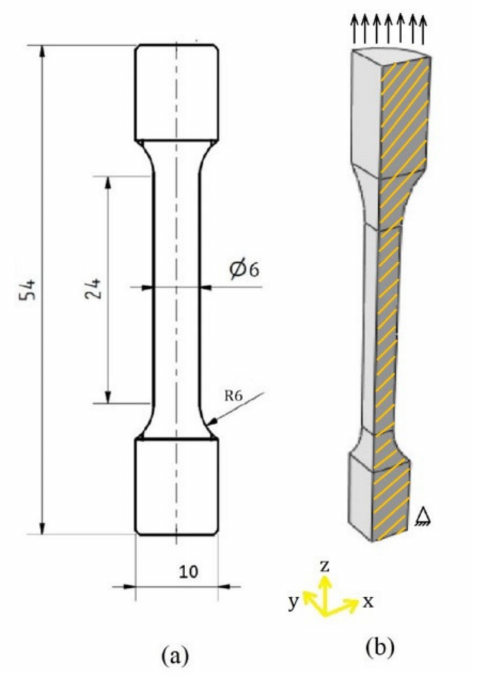
Figure 2. ( a ) Specifications of tensile specimen (all units are in mm) ( b ) tensile model for simulation. Displacement controlled loading was applied with the boundary condition of keeping one side fixed, while displacement loading is applied on the other end, as shown in Figure 2b. Two additional boundary conditions were used based on the assumption that the cross-section of the specimen remains circular during the tensile test; in xz plane (shaded by yellow color in Figure 2b), displacement and rotation perpendicular to the plane were kept zero i.e., u y = ur x = ur y = 0 and similarly, in the yz plane, u x , ur y , and ur z were kept